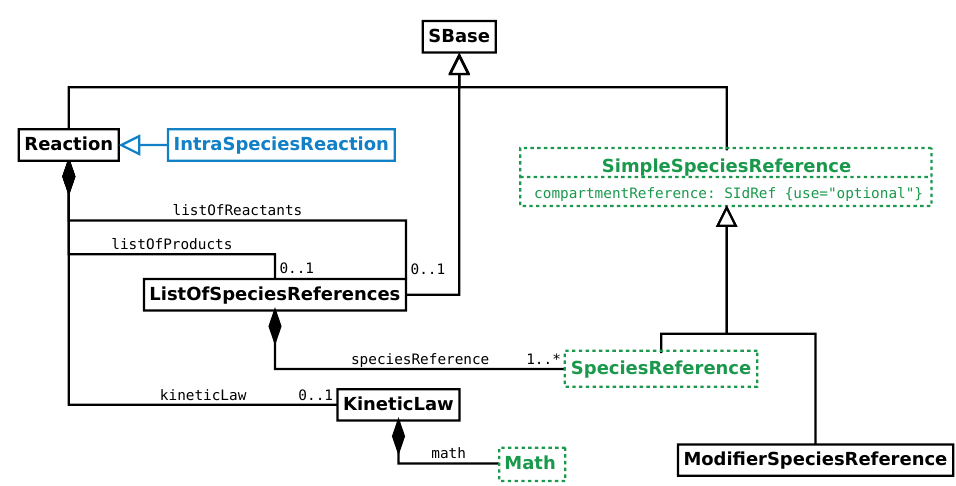
Figure 14: The changes under the Reaction class including IntraSpeciesReaction , SimpleSpeciesReference , Species- Reference and